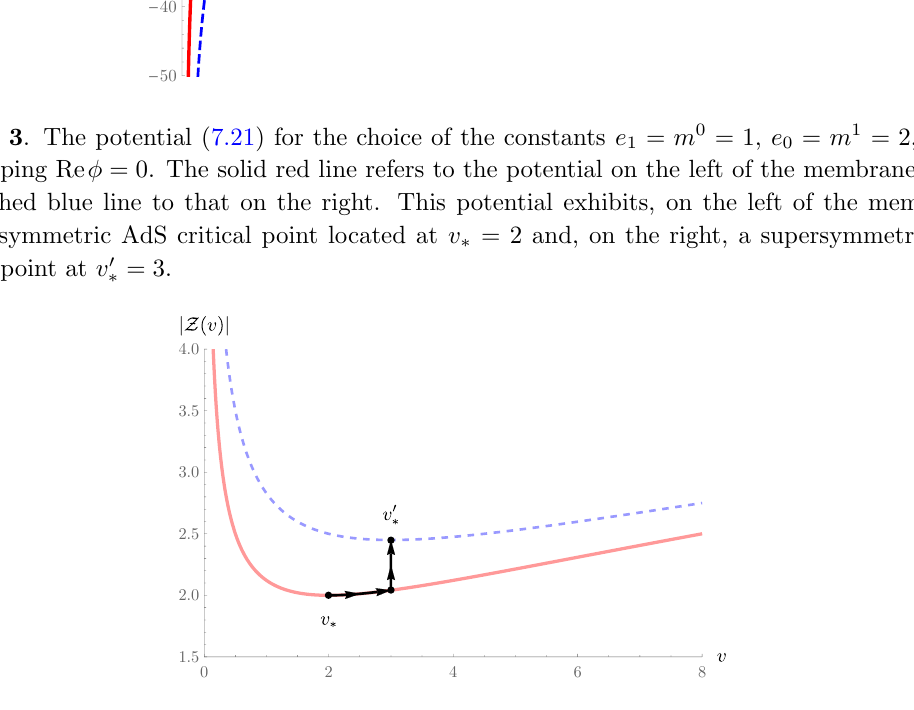
Figure 4 . The (cid:13)ow of jZj for the same set of parameters as in (cid:12)gure 3. The solid red line refers to jZj on the left of the membrane, while the dashed blue line to that on the right. The (cid:13)ow drives v (cid:3) towards the value v 0 , at which jZj jumps so that v is located at new supersymmetric vacuum on (cid:3) the